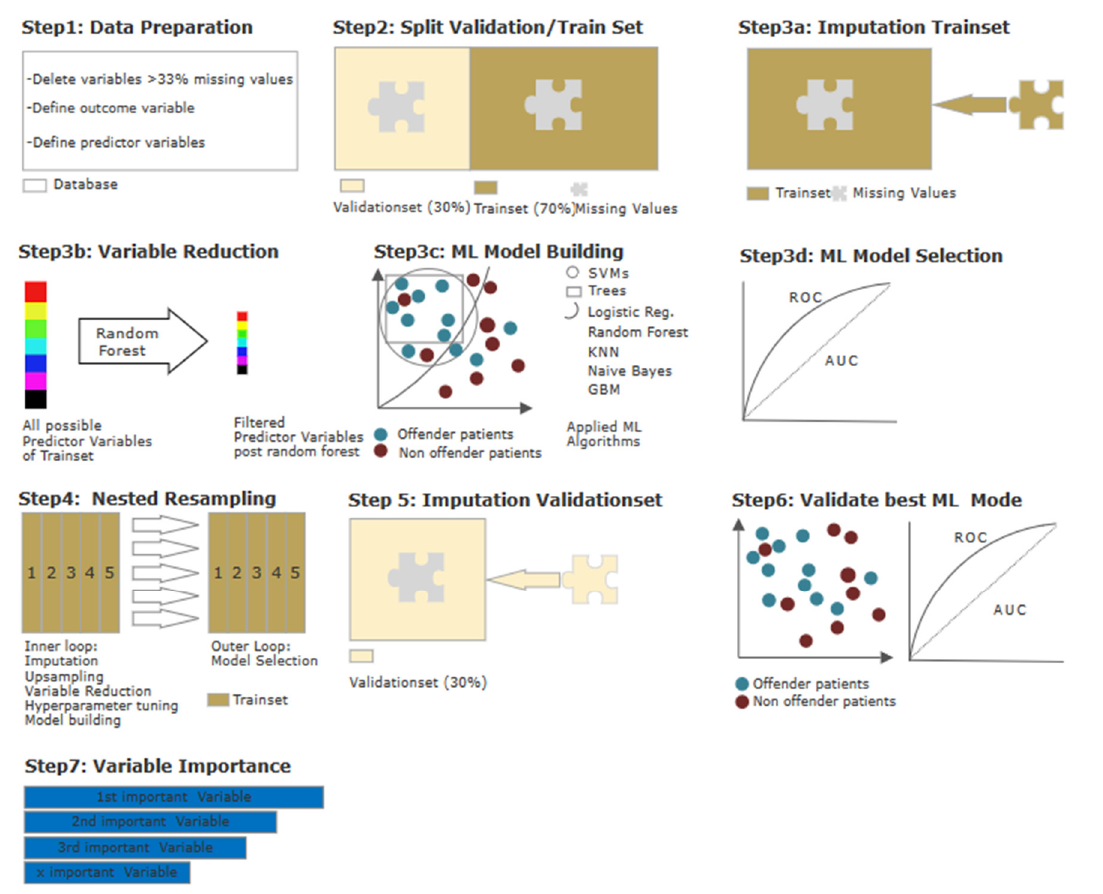
Figure 1. Statistical procedures using machine learning (ML). Step 1—Data preparation: Conversion of categorial variables to binary code. Outcome variable OP/NOP and predictor variables were de- fined. Omission of variables with missing values of 30% or more Step 2—Data splitting: 70% training dataset and 30% validation dataset. Step 3a–d—Model building and selection (a): Imputation by mean; (b) variable reduction via random forest; (c) model building using ML algorithms ( d ) selec- tion of most suitable ML algorithm via ROC parameters. Step 4—Model building and testing on training subset: Step 5—Imputation by mean on validation set. Step 6—Model building and testing tion dataset, evaluation via ROC parameters. Step 7—Test for multicollinearity and ranking of var- iables.